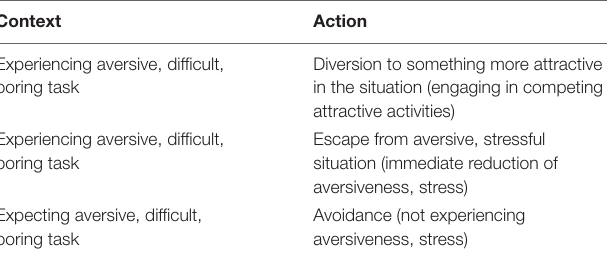
TABLE 1 | Common contexts for behavioral